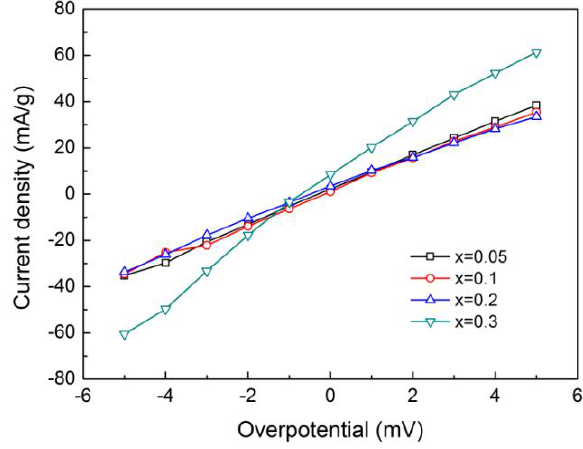
Figure 7. Linear polarization curves of La